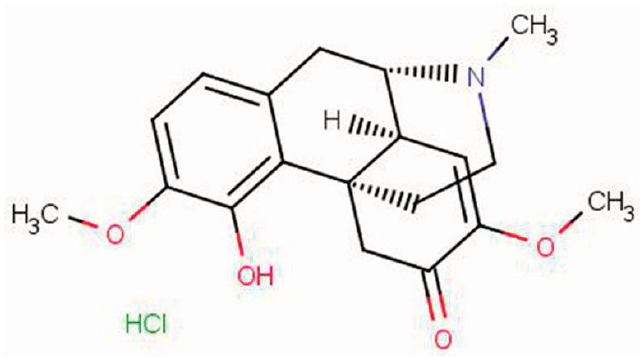
Figure 1. The structure of sinomenine hydrochloride